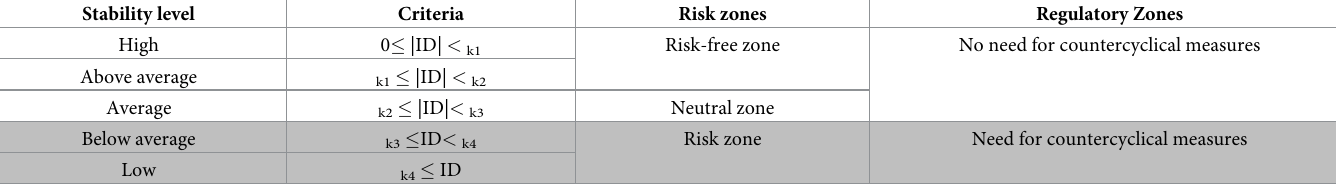
Table 1. Criteria for financial